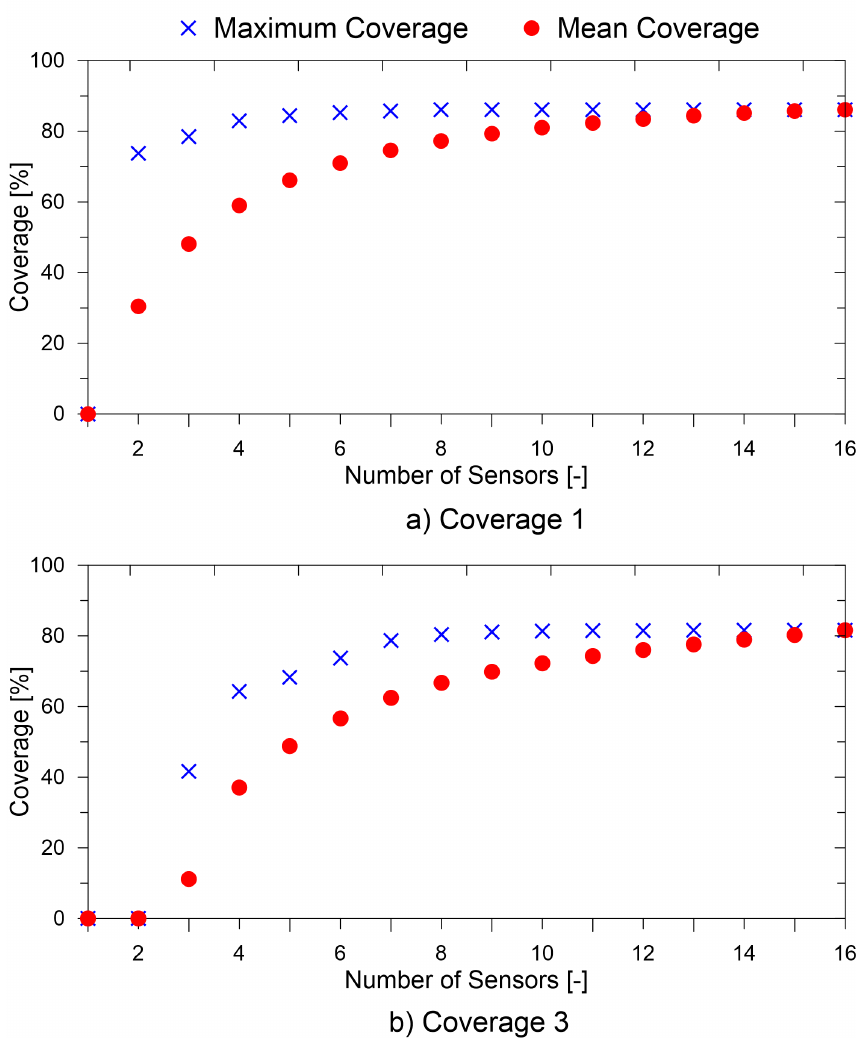
Figure 16. ( a ) Relation of objective Coverage 1 with the number of sensors; ( b ) Relation of objective Coverage 3 with the number of sensors.